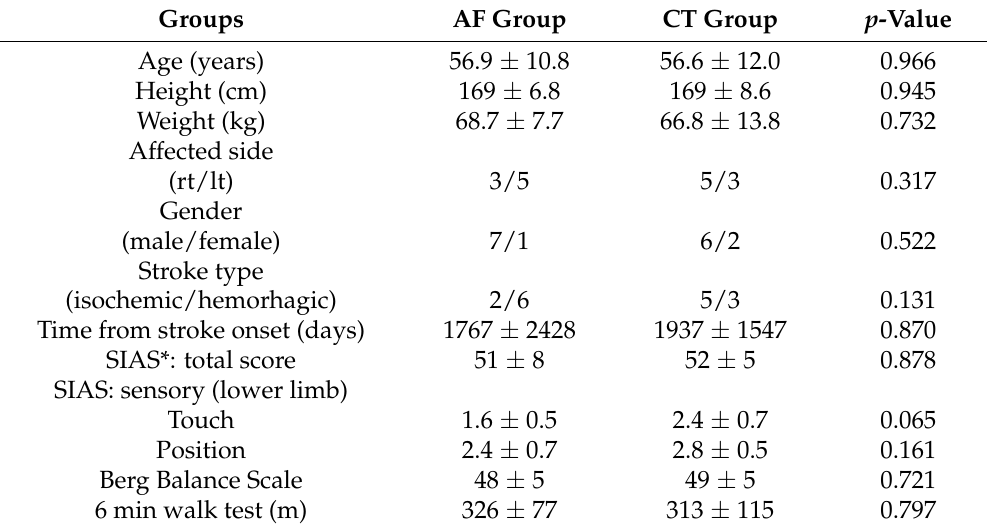
Figure 2. Nineteen patients after stroke participated in this study and eighteen patients completed the rehabilitation period. A patient dropped out for onset of cerebral infarction. Two additional patients were excluded from the following analysis because of their slow walking speed. Table 1. Demographic and clinical characteristics of the subjects. No significant between-group differences were found in the